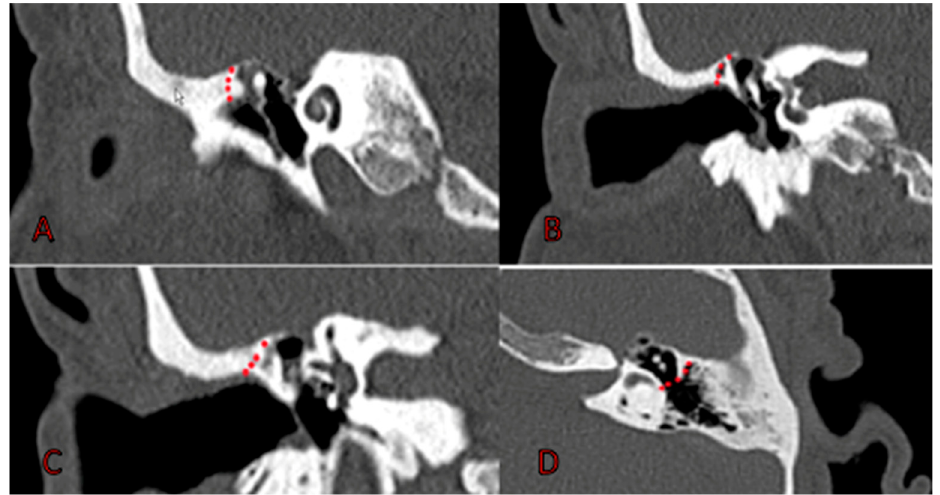
Figure 3. AE-AE hybrid exteriorization technique. ( A – C ) atticotomy starting anteriorly and progressing posteriorly without affecting the posterior wall or entering the antrum. ( D ) antrum exclusion with pieces of cartilage.